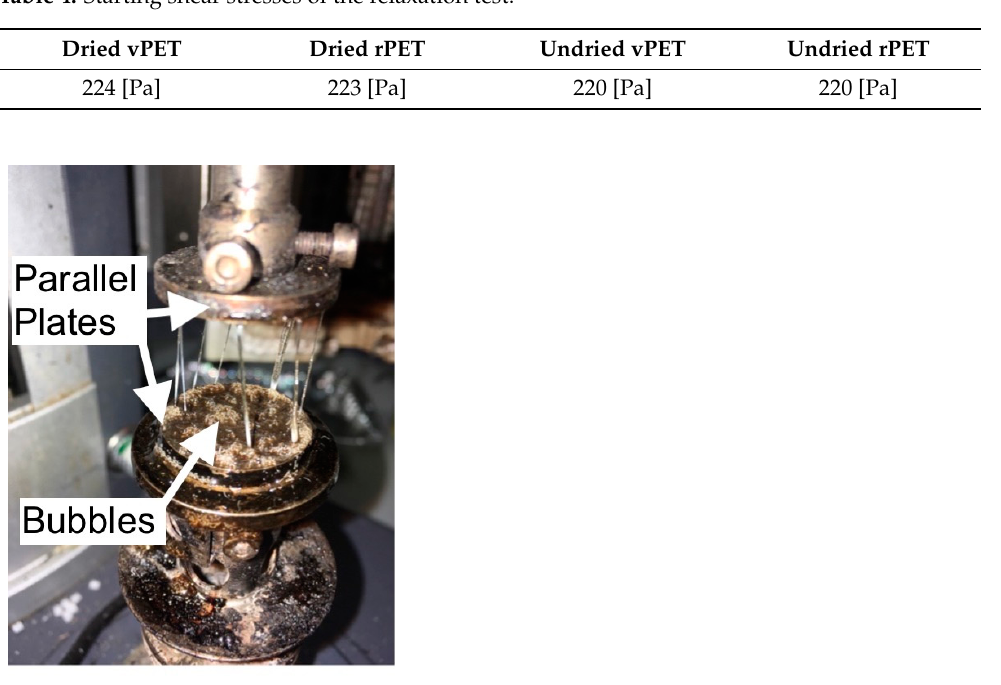
Figure 7. Shear stress curves of the relaxation test. Table 4. Starting shear stresses of the relaxation test.